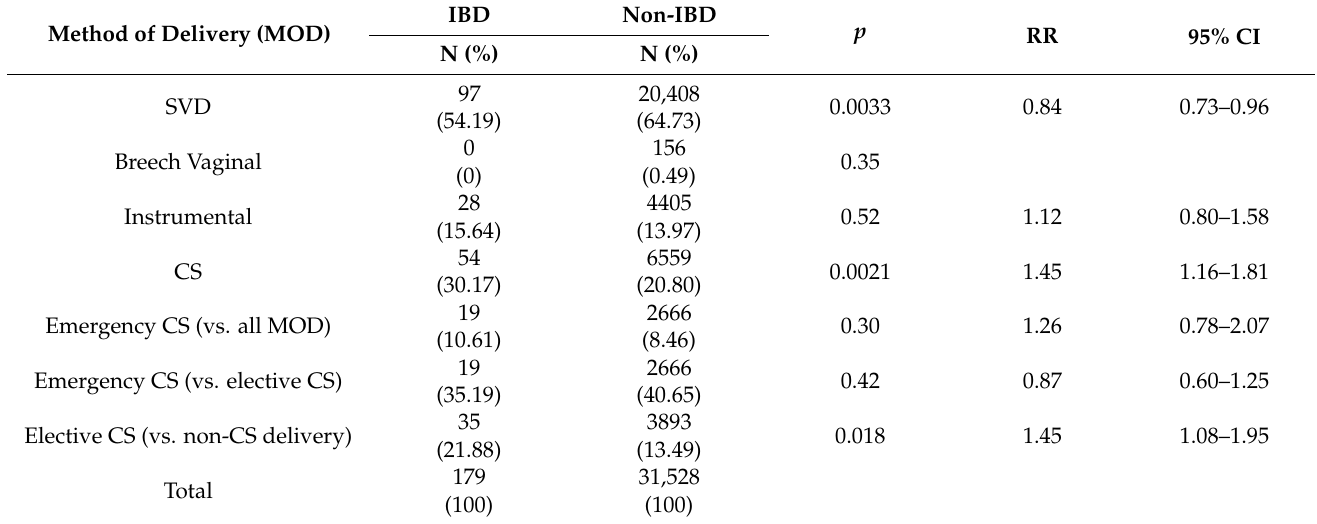
Table 3. Mode of